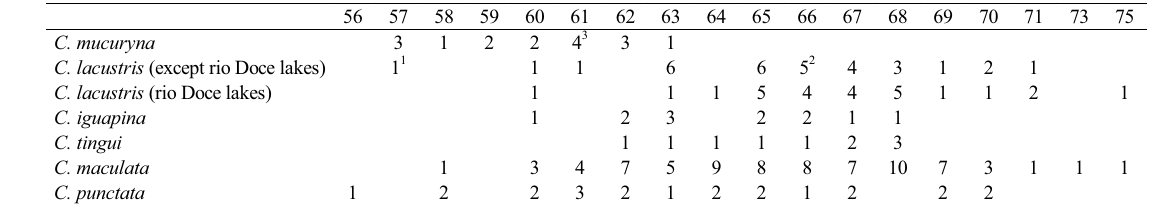
Table 4. E1 scale count frequencies in species of Crenicichla . 1 MNHN A9501 (126.0 mm), syntype of C. lacustris ; 2 includes FMNH 54155 (117.0 mm), some scales missing; holotype of C. dorsocellata ; 3 includes lectotype of C. mucuryna MZUSP 2526 (113.3